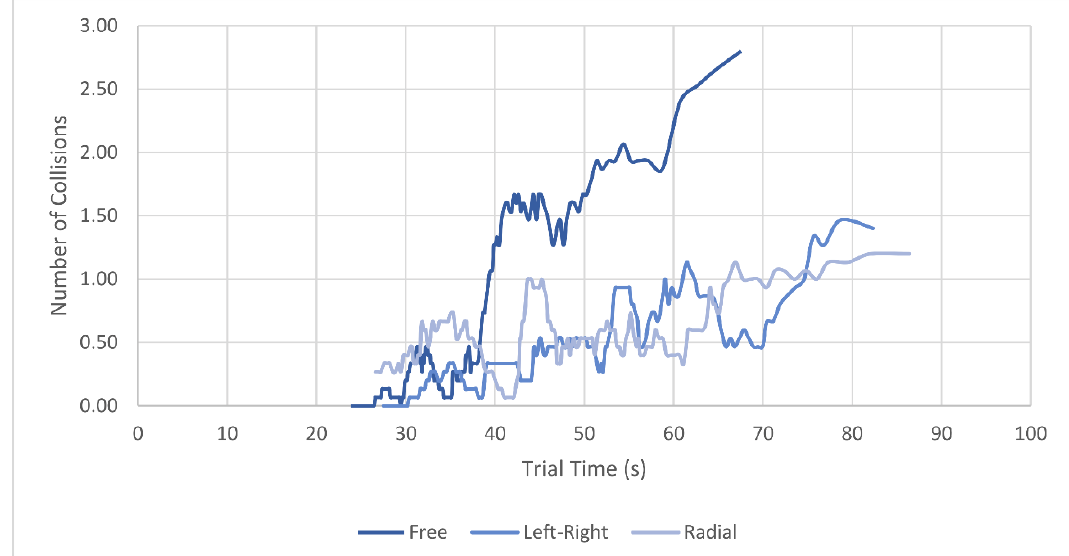
Figure 5. The moving average of the number of collisions by trial duration in the three conditions (period of 15). This visualizes how the number of collisions in trials of similar duration varied between the different scanning pattern conditions. The results shown are from the main participant group.